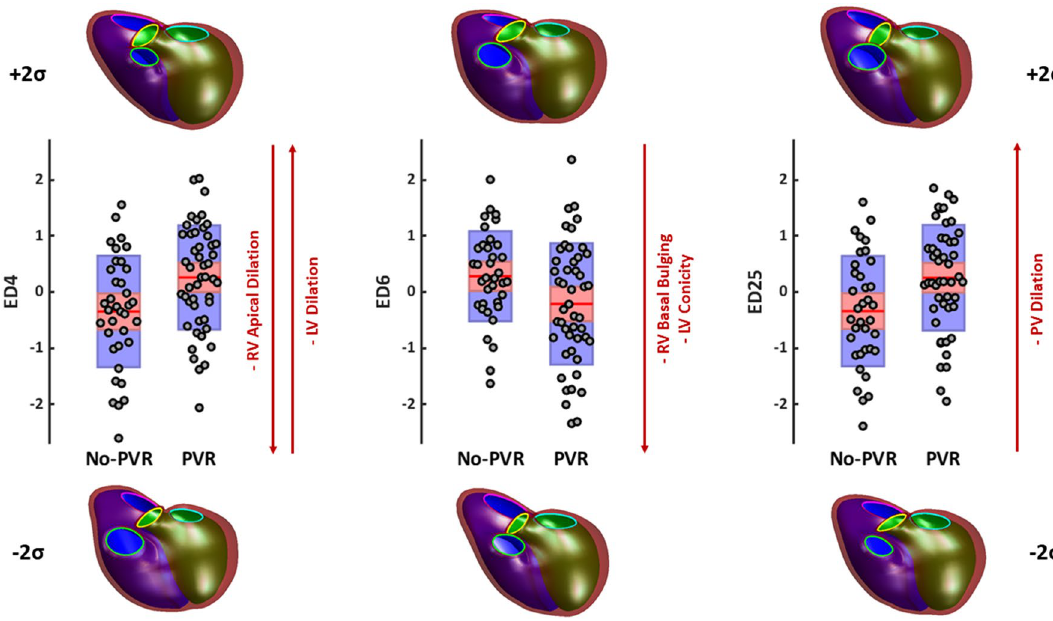
Figure 2. Shape modes that have significant associations with PVR status. Box plots show mean (red line), 95% confidence intervals of the mean (pink shaded bar), and one standard deviation of the mean (blue shaded bar) for Z-scores (gray circles). Models show mean ED shape plus two standard deviations (top) and minus two standard deviations (bottom) for each mode. The LV endocardial surface, RV endocardial surface, and epicardial surface are shown in green, purple, and maroon, respectively. The mitral, tricuspid, aortic, and pulmonary valves are shown in cyan, pink, yellow, and green, respectively. LV Left ventricular, PV Pulmonary valve, RV Right